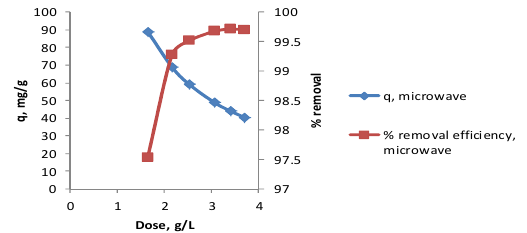
Fig.3a. Effect of mass change on adsorption of MB on AC prepared